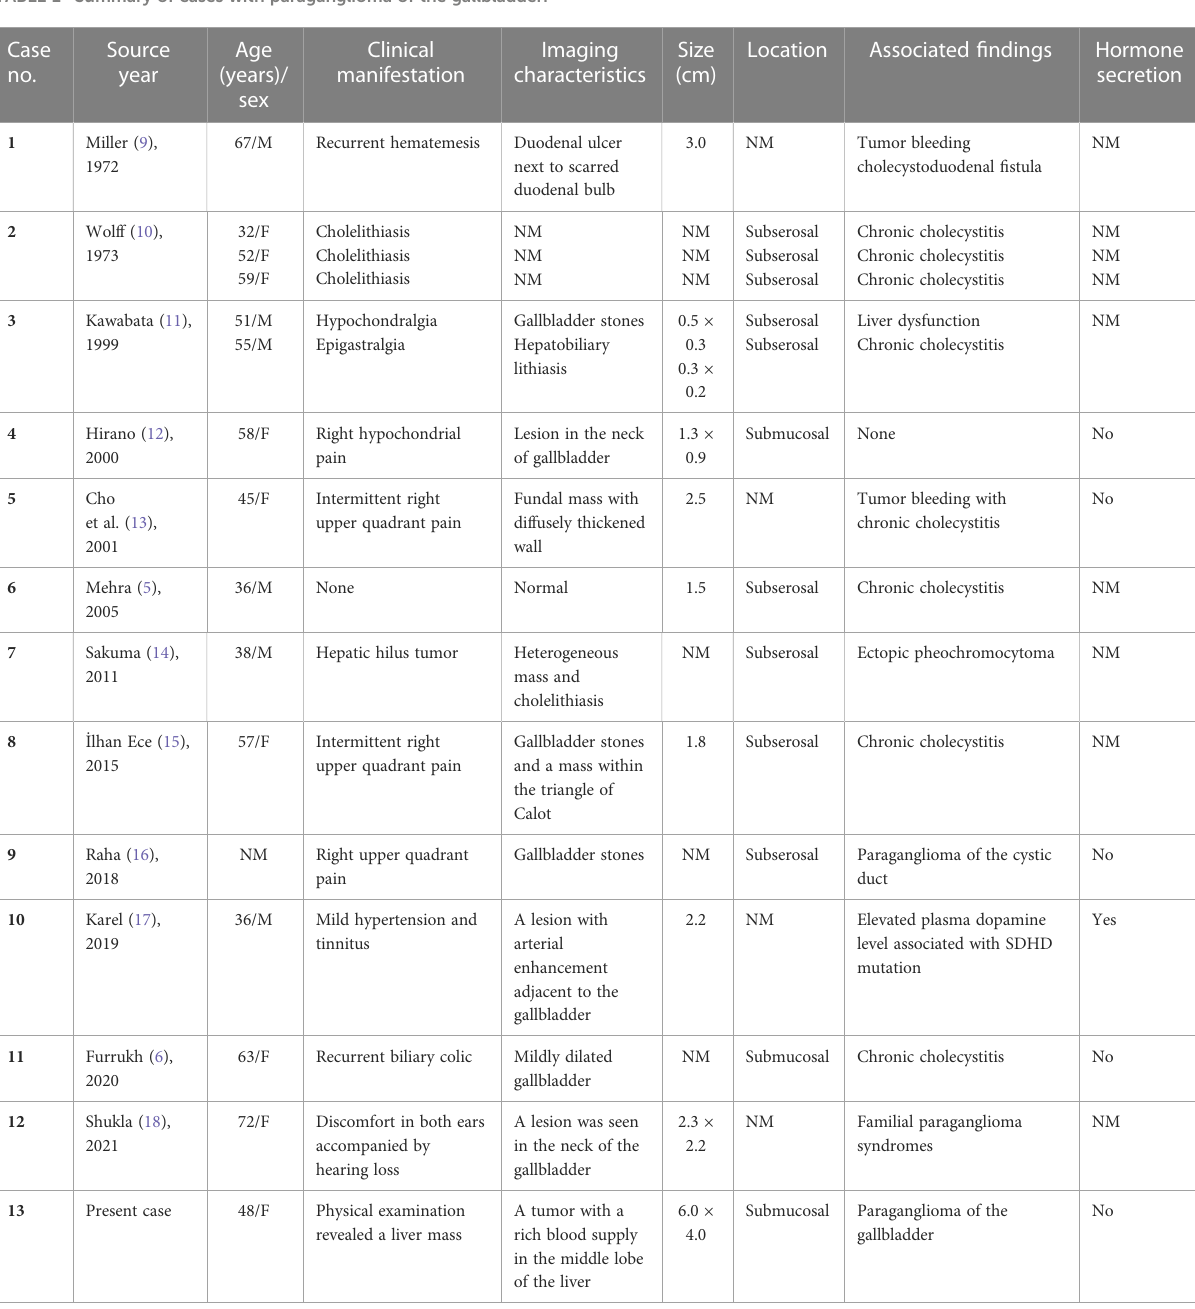
TABLE 1 Summary of cases with paraganglioma of the gallbladder. Case